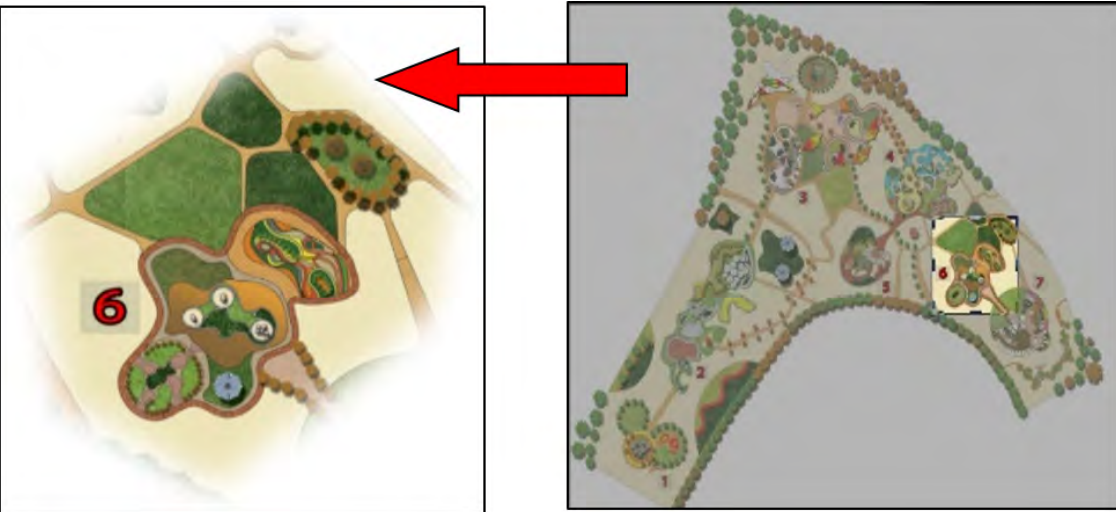
Figure 24. The location of “Natural Trail” zone